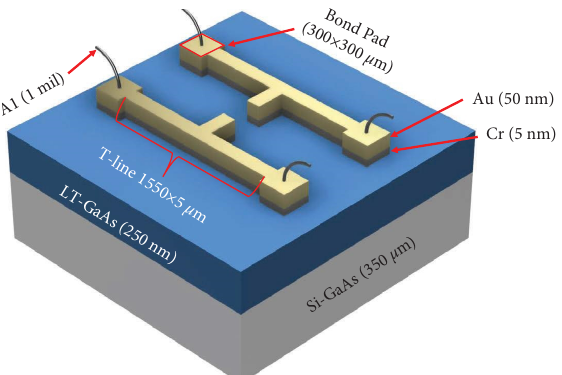
Figure 13: Fabricated 3D model of THz PCA emitter device stack (not to scale). Te metallic electrodes represented in yellow color in this sketch were fabricated in four diferent shapes as demonstrated in Figure